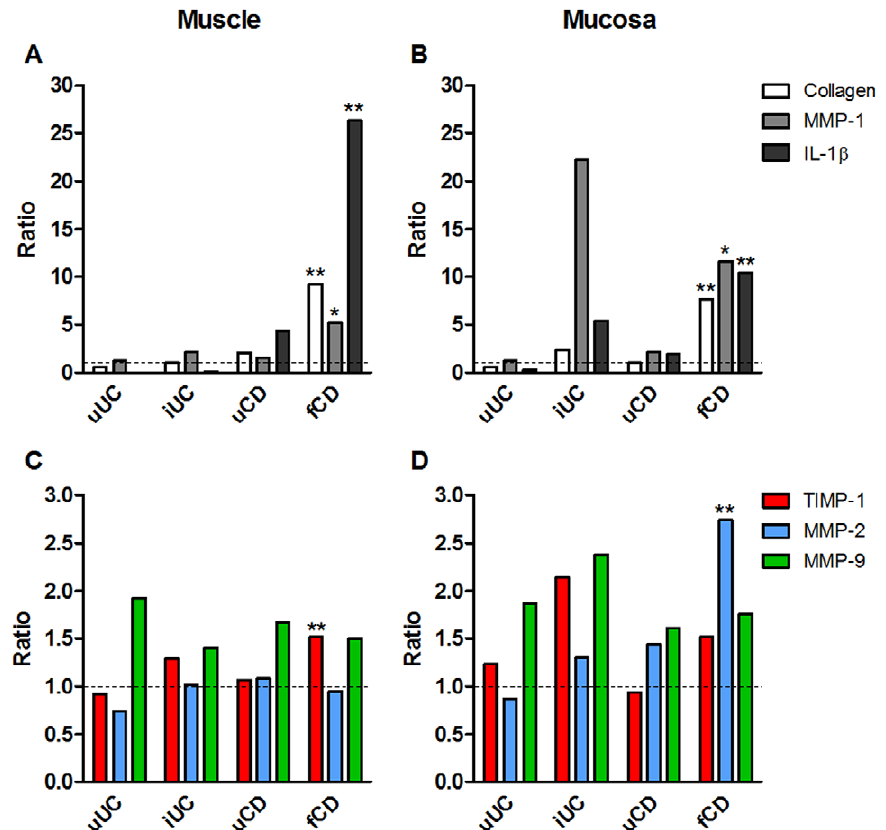
Figure 2. Fibrogenesis is increased in CD muscle and mucosa tissues, without concomitant MMP-2 synthesis in muscle. Tissue fragments were extracted and analysed by ELISA (collagen CICP synthesis, IL-1 b , MMP-1, TIMP-1, TIMP-2) or zymography (MMP-2, MMP-9). Data are expressed as the ratio of the group mean for uUC, iUC, uCD or fCD to the mean for cancer control tissue for each parameter. Data are derived from 14–15 cancer controls, 3 uUC, 8 iUC, 8–12 uCD and 14–21 fCD patients. See Table S4 for actual means and SEM for each parameter. *p , 0.05, **p , 0.01 to cancer controls.